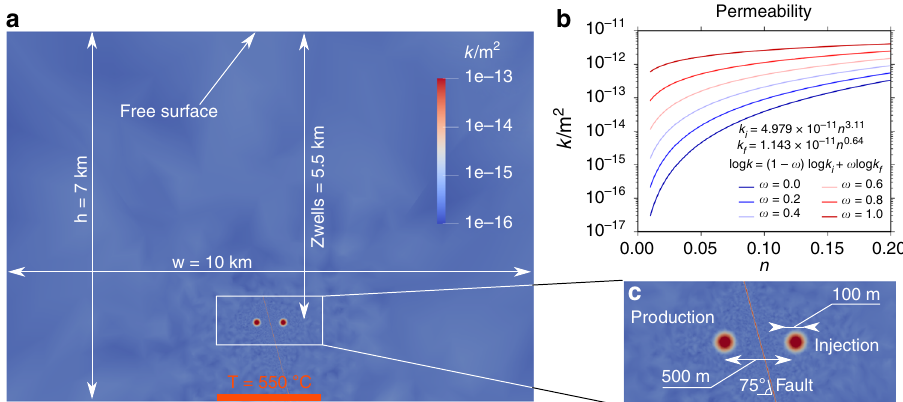
Fig. 2 Numerical model and equivalent permeability. a Model setup of the complete reservoir for initialisation phase, in which a constant bottom temperature is applied to initialise the thermal plume. b Permeability curves of volcanic rocks are function of porosity 50 in a logarithmic relation with ω representing the degree of fracturing of the rock. c Detail of the geothermal doublet located at 5.5 km depth with the fault between the wells and